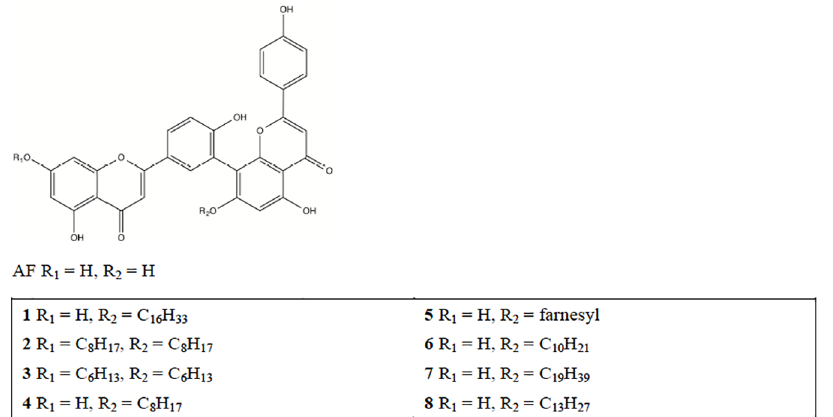
Fig 1. Chemical structuresof amentoflavone (AF) and analogues